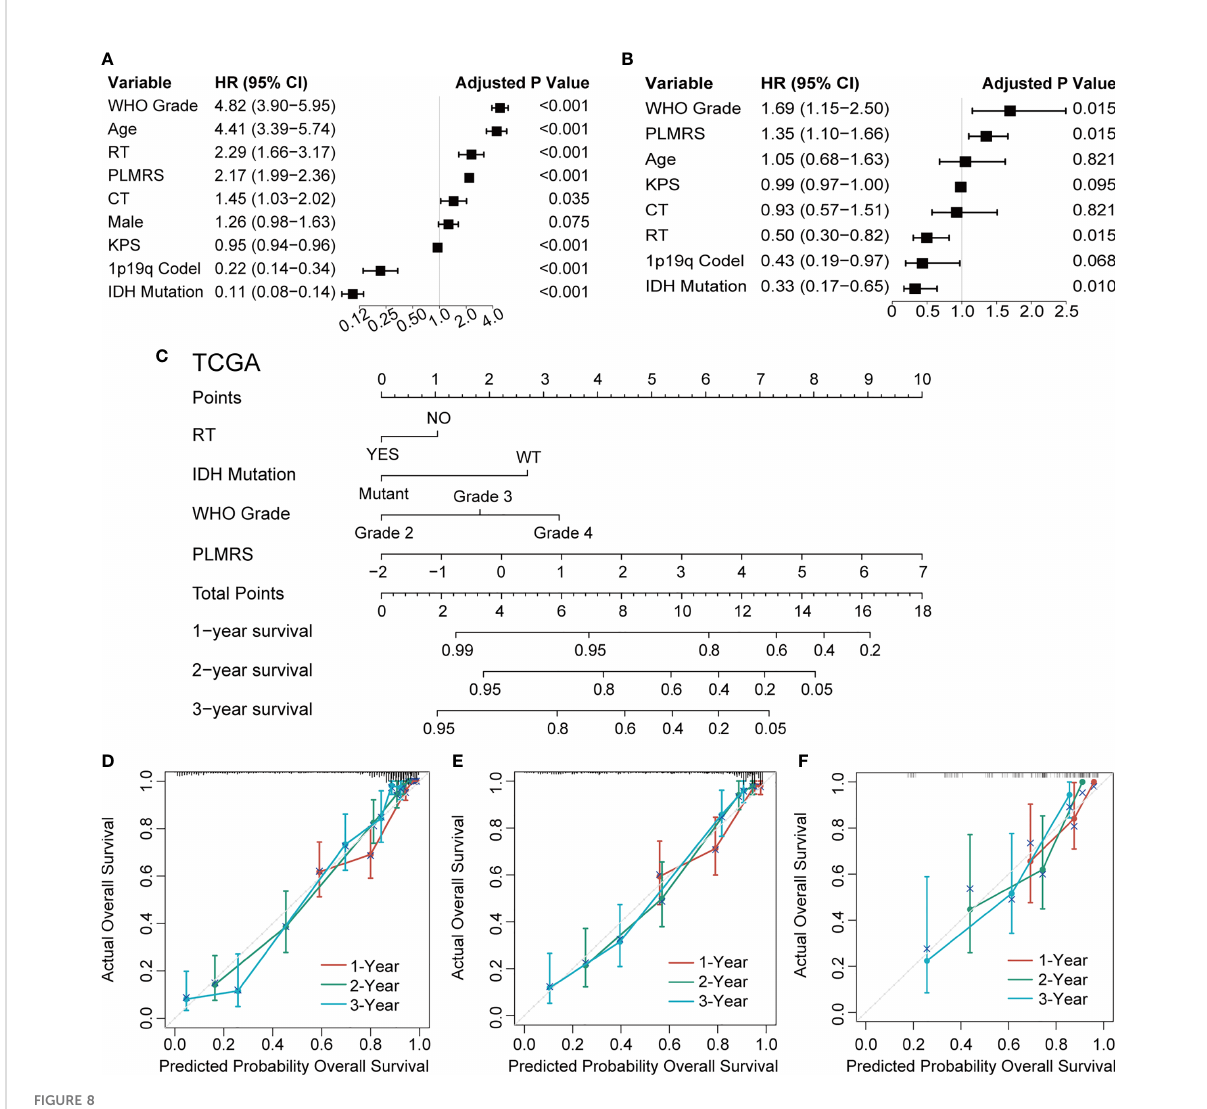
FIGURE 8 Nomogram construction and validation. Univariate (A) and multivariate (B) Cox regression to identify independent prognostic factors. (C) Nomogram of 1-, 2-, 3-year survival of glioma established in TCGA. Calibration plots of nomogram developed by TCGA (D) , CGGA (E) and WCH (F) . TCGA, The Cancer Genome Atlas; CGGA, Chinese Glioma Genome Atlas; WCH, West China Hospital; WHO, World Health Organization; PLMRS, prognostic lactate metabolism risk score; RT, radiotherapy; CT, chemotherapy; KPS, Karnofsky Performance Score; IDH, isocitrate dehydrogenase; WT, wild